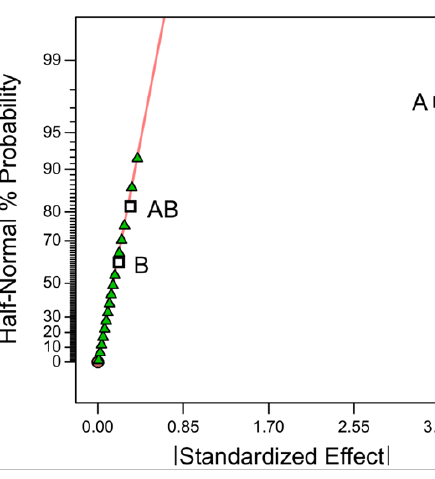
Figure 12. Normal probability plot for SBS test. Appl. Sci. 2020 , 10 , x FOR PEER REVIEW